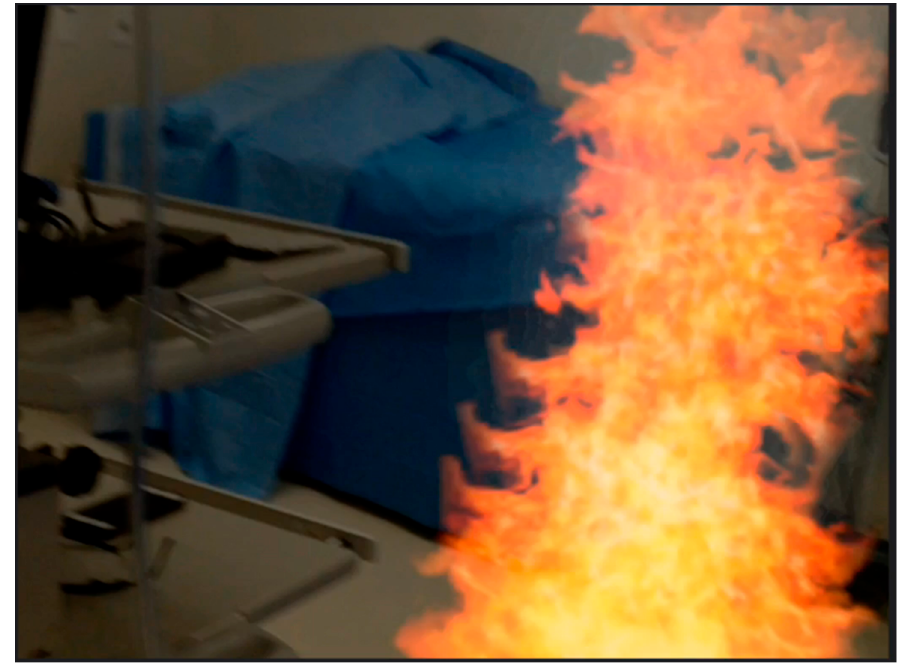
Figure 5. Student view of fire near the bedside. Source: University of Miami IT Department.